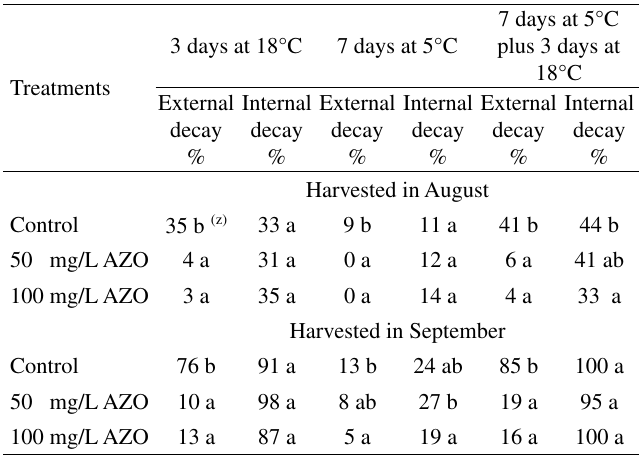
Table 3 - Influence of 30-s-dip-treatments with azoxystrobin (AZO) at 20°C on external and internal decay incidence in second crop ‘Perdingiana’ figs after three days at 18°C and 65% RH, or for seven days at 5°C plus three days at 18°C